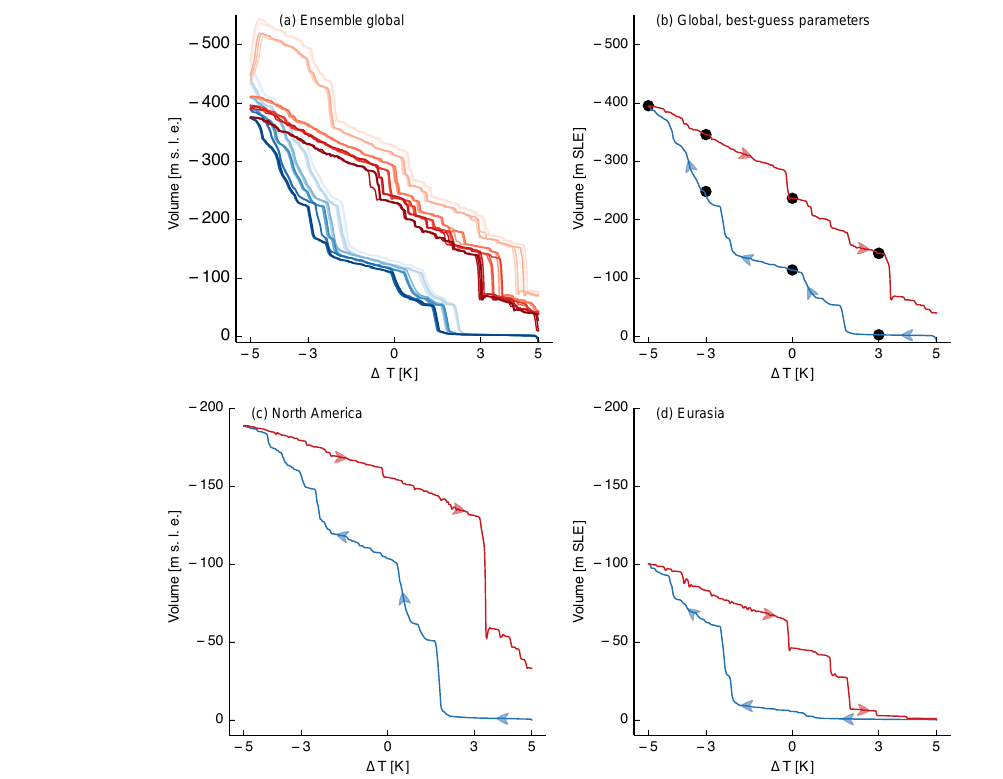
Figure 11. Global (a, b) and regional (c, d) ice volume as a function of global temperature offset. Increasing temperatures are in blue, and decreasing temperatures in red. On the top left (a) is an ensemble with 18 members (Table 5) indicating the robustness of the hysteresis behavior in a range of parameter values. All other plots (b–d) are from the simulation with the best-guess parameter (same as in Fig. 9, left). The dots denote (b) the ice volume in equilibrium at the specific temperature. Considered areas for North American and Eurasia are highlighted in Fig.